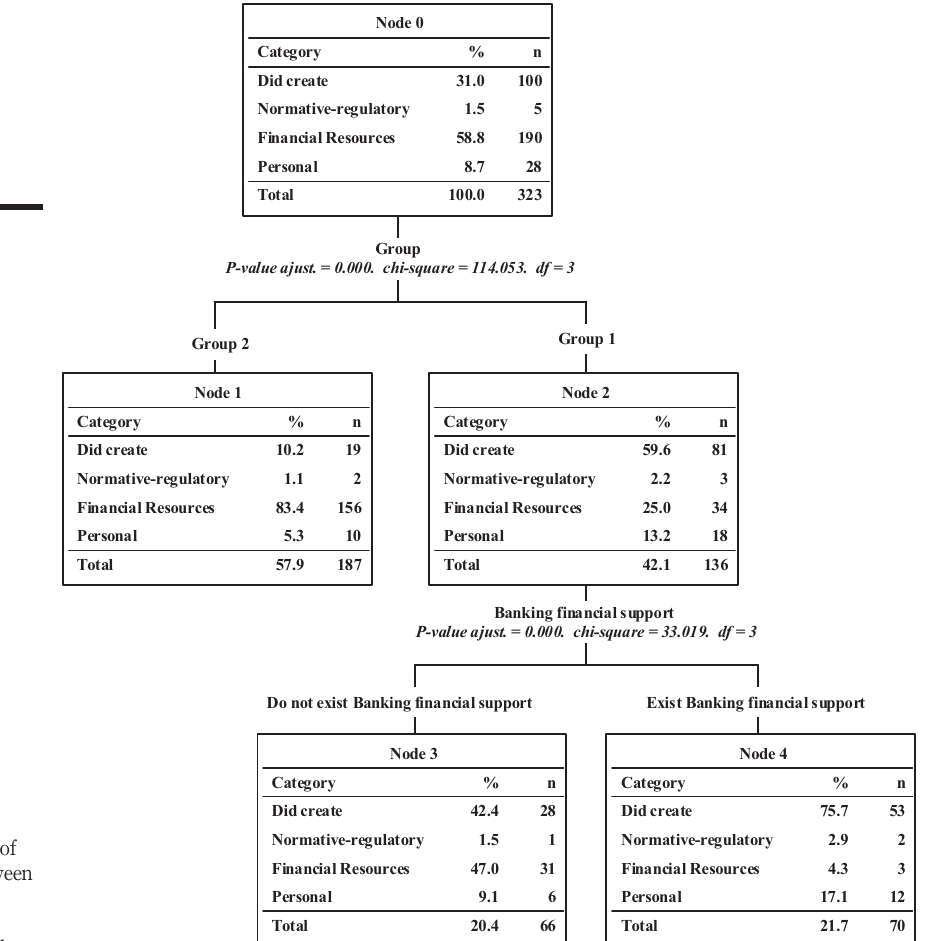
Figure 3. CHAID diagram of relationship between the barriers, the group and the banking fi nancial